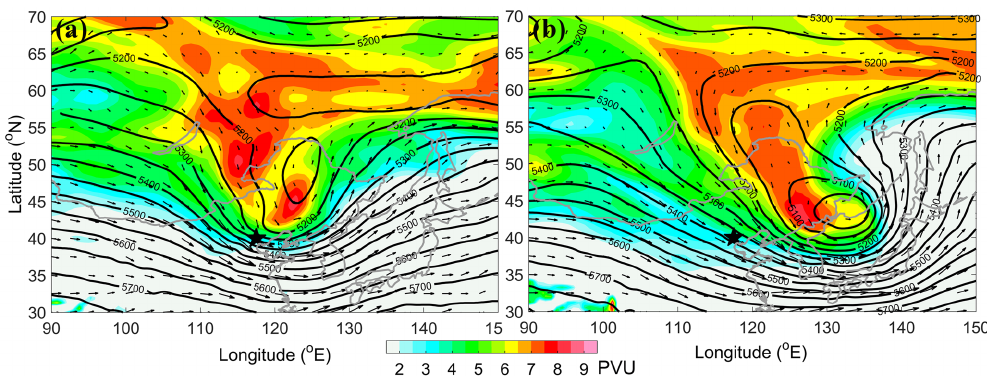
Figure 2. ECMWF-derived isentropic PV map on 315K surface (shaded above 2pvu, 1PVU = 10 − 6 m 2 Kkg − 1 s − 1 ) and geopotential height (contoured every 50m in solid line) along with the wind vector (arrow) at 500hPa ( ∼ 5 . 5kma.s.l.) on (a) 18:00UTC 30 November 2014 and (b) 12:00UTC 1 December 2014. The black star shows the location of Xianghe.